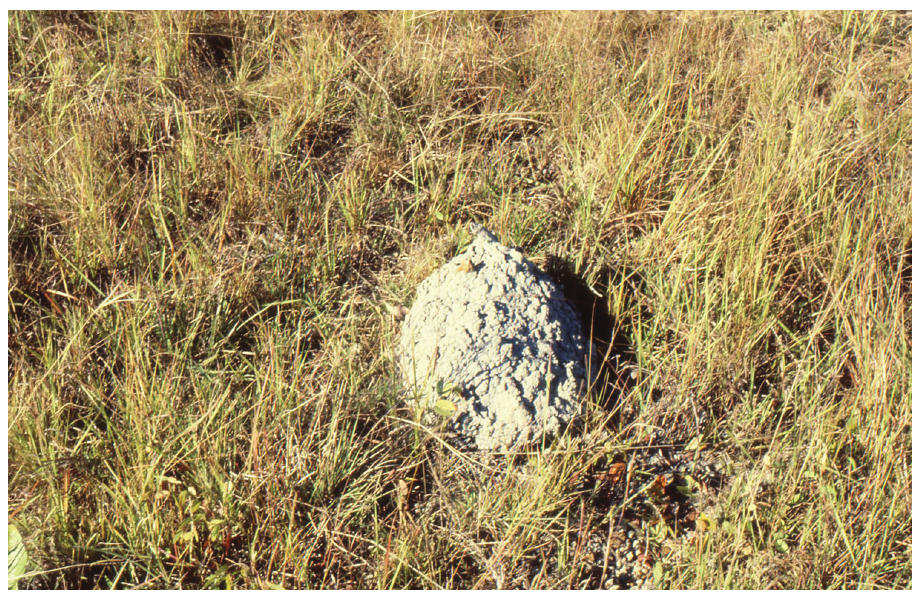
Figure 7. Termite mound of Armitermes sp., natural habitat of the new species in the Campos of Pará (photograph by the author,